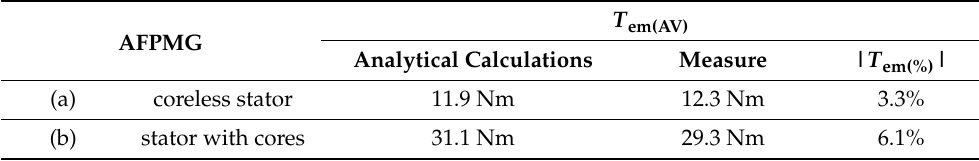
Table 5. Comparison of the results obtained from analytical models and laboratory tests for average value of the electromagnetic torque.